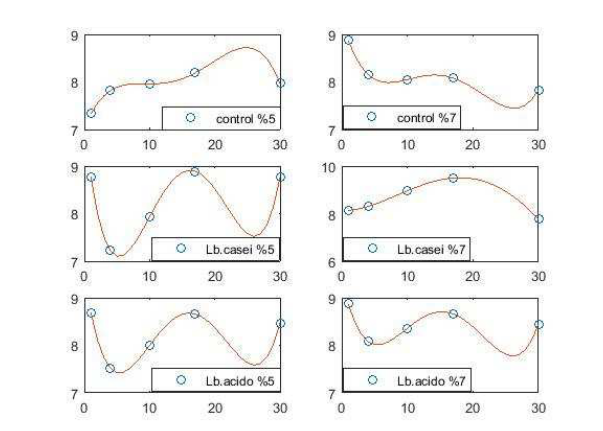
Figure 9. The graphics of the mem- bership functions for lactic acid bacte- ria numbers (the x-axis represent the days and the y-axis represent the lac- tic acid bacteria numbers).